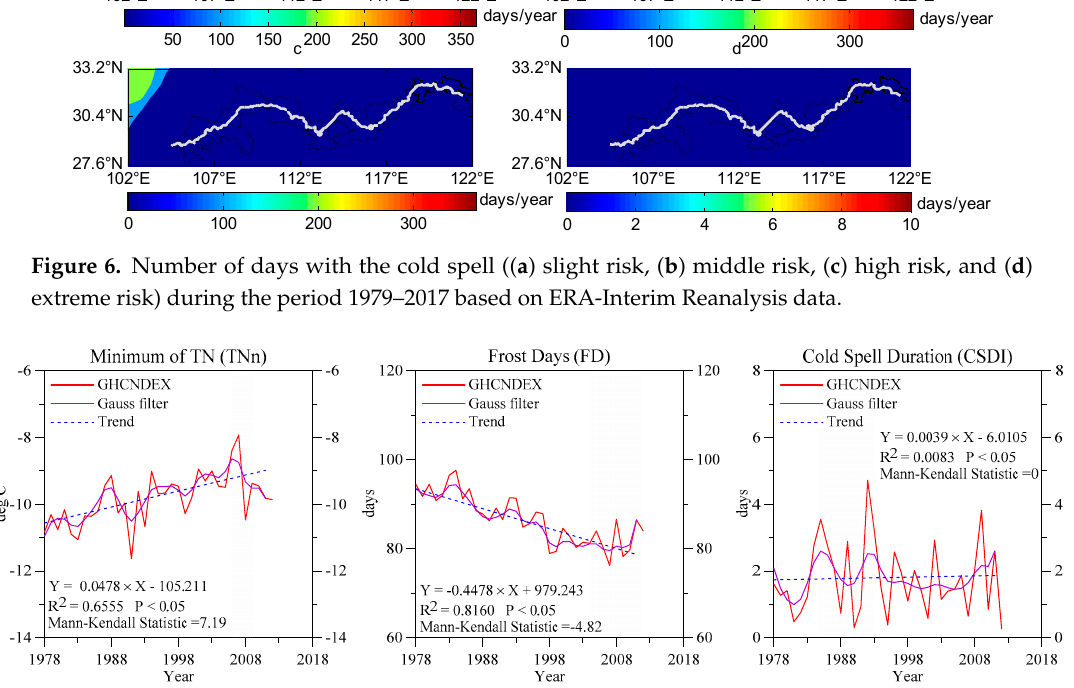
Figure 7. Time series of area-averages cold spell indices (TNn, FD and CSDI, and the gray area indicates a more significant variability) during the period 1979–2017 based on GHCNDEX data.